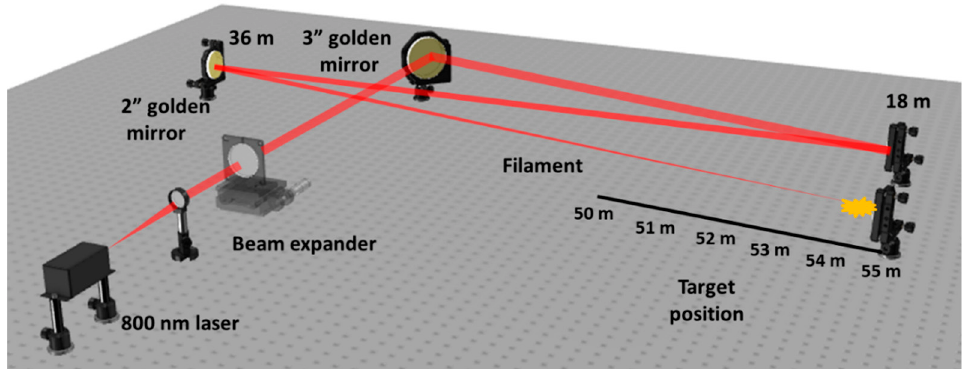
Figure 1. Experimental setup to launch the filament at long distances. Filament-induced LIPSS were studied across the range of 50–55 m from the laser exit. The laser beam was folded a few times before the filament was formed using gold-coated mirrors to reach the 55-meter target position inside the laboratory.